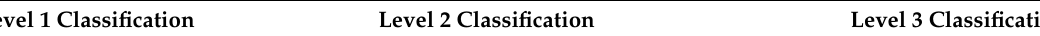
Table 2. Table of automobile crash safety